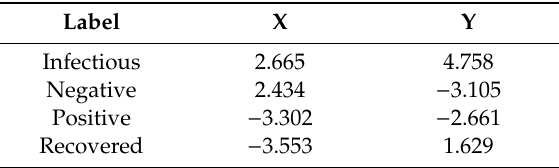
Table 3. Class Center Gravity Coordinates.